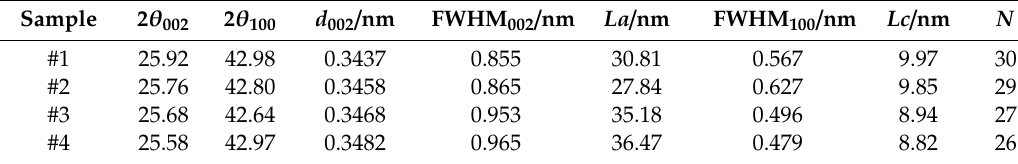
Table 2. XRD structure parameters of each carbonaceous deposit layer in the coking chamber.